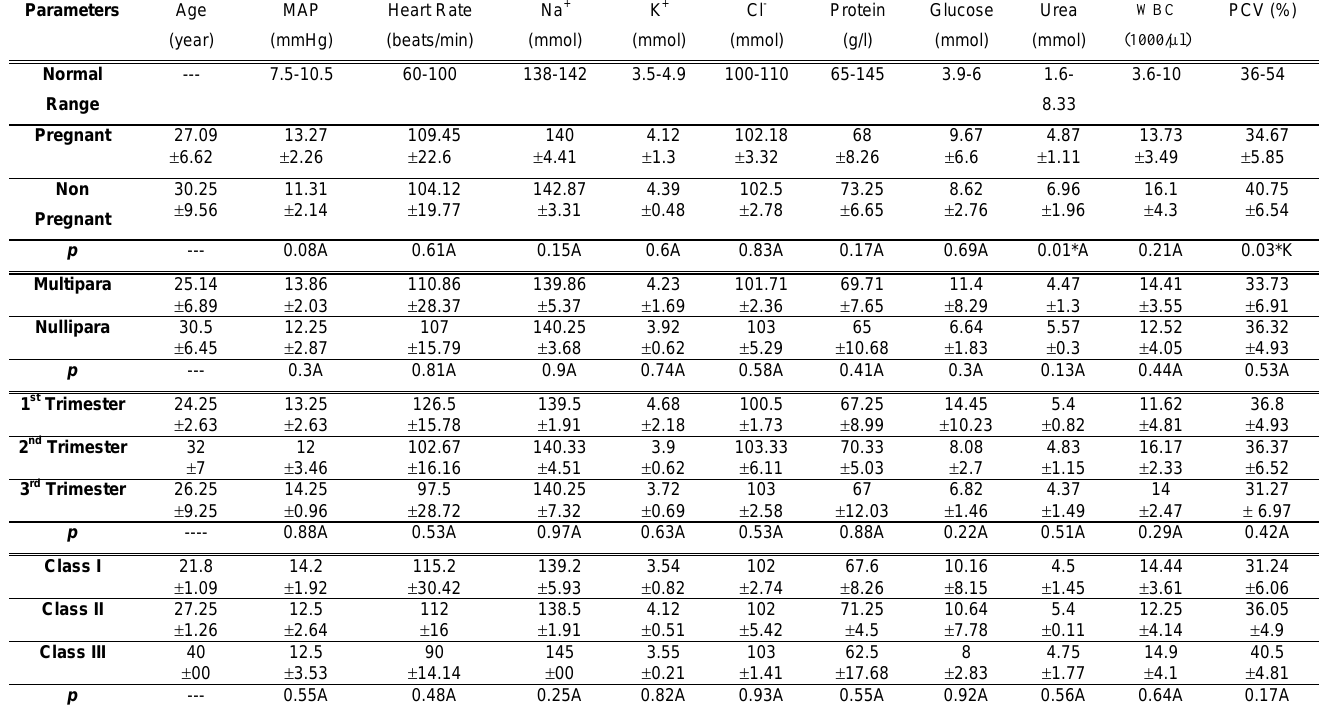
Table 2: Variability of clinical and laboratory parameters of scorpion-envenomed patients according to maternal age, gestational age and number of previous parities, and comparison between pregnant and non-pregnant patients envenomed by